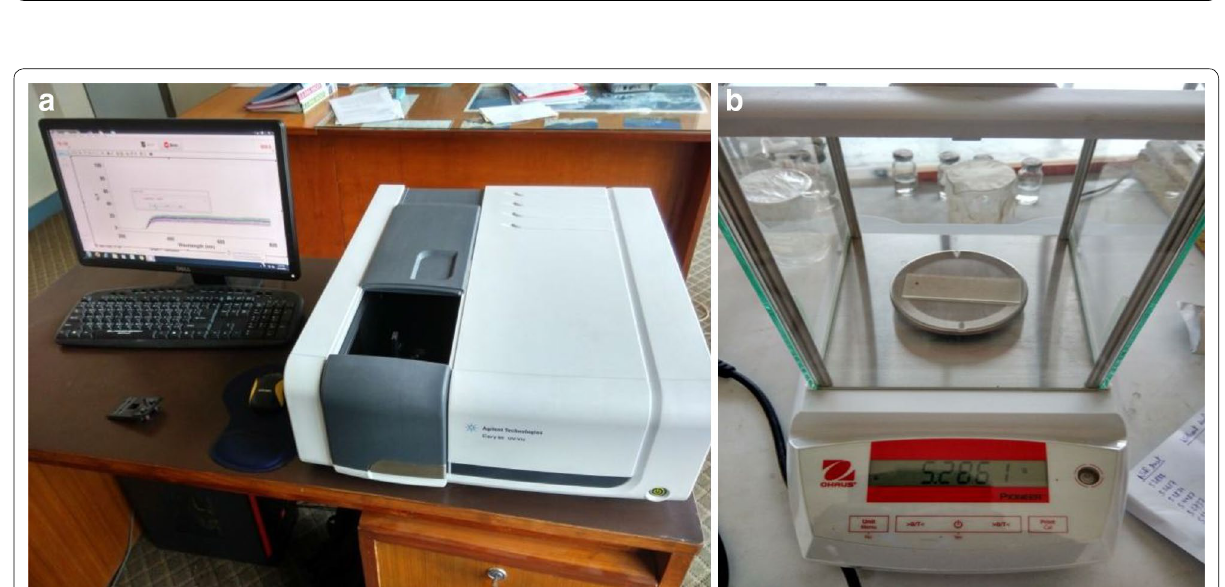
Fig. 2 a , b Transmittance and dust deposition density data collection